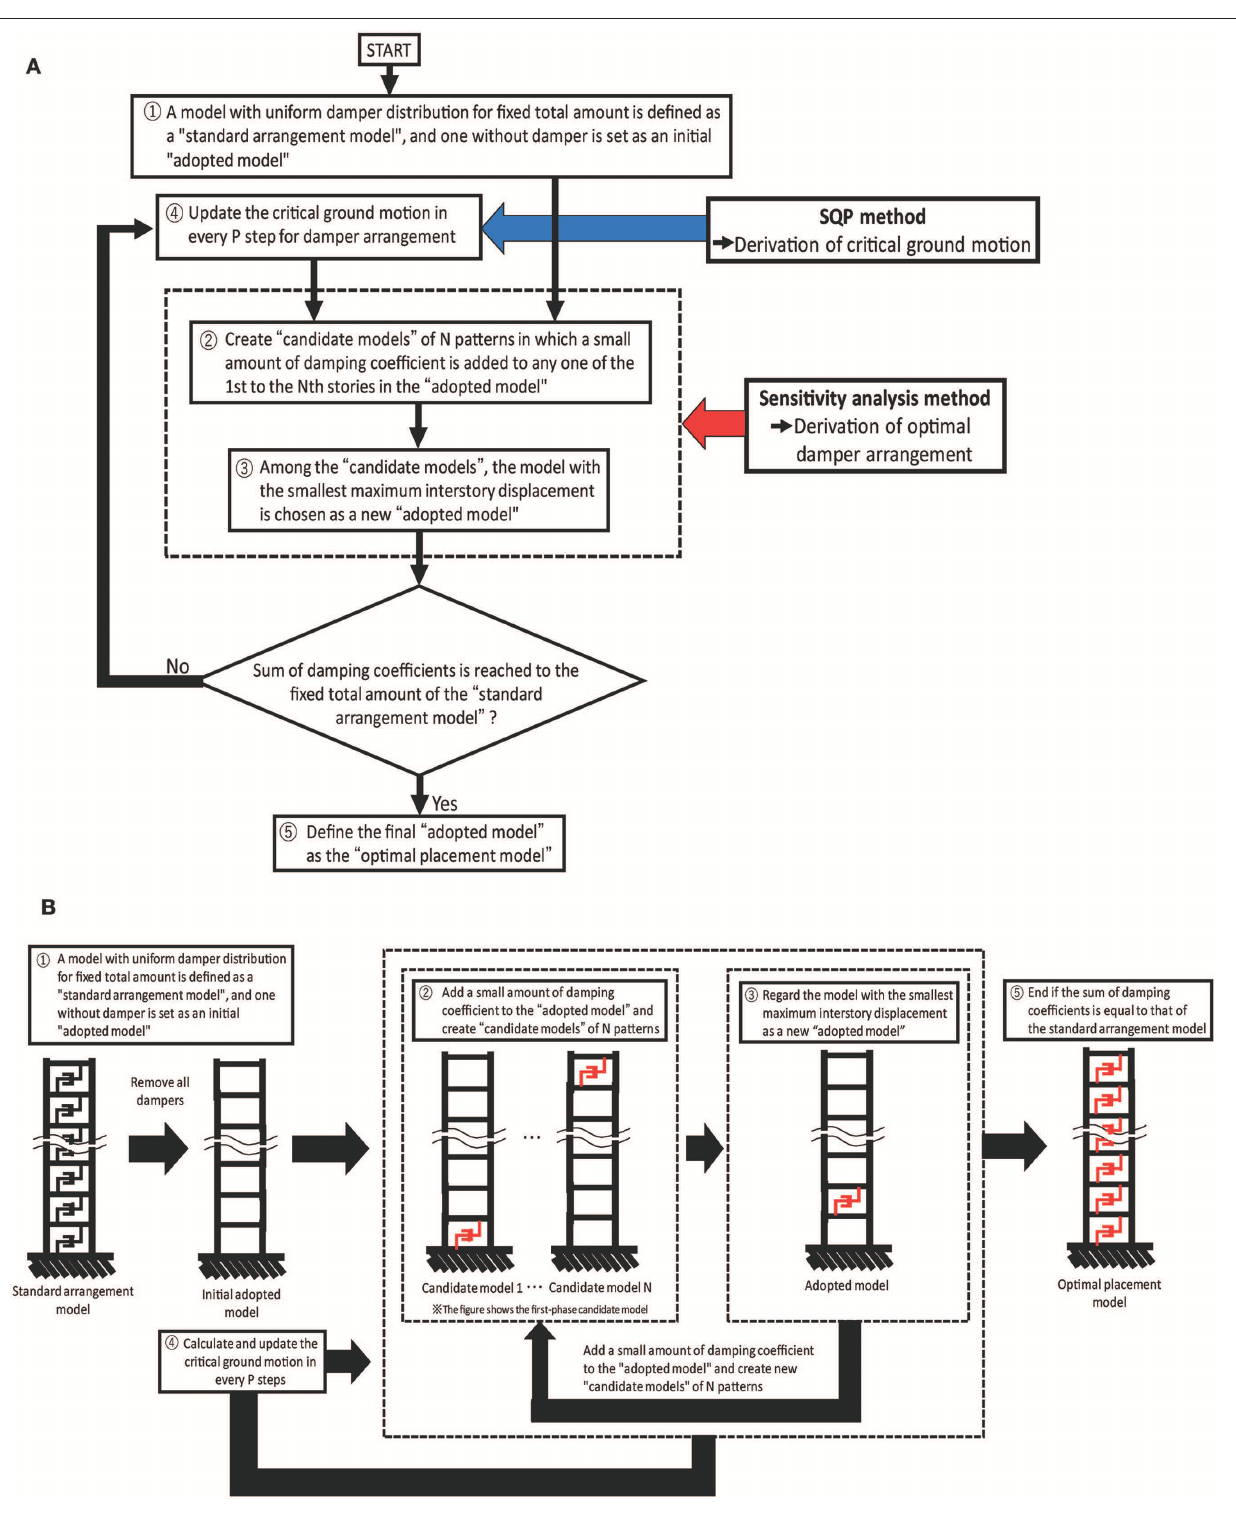
FIGURE 2 | Simultaneous implementation of critical ground motion generation and optimal damper placement, (A) flow chart, (B) conceptual diagram.